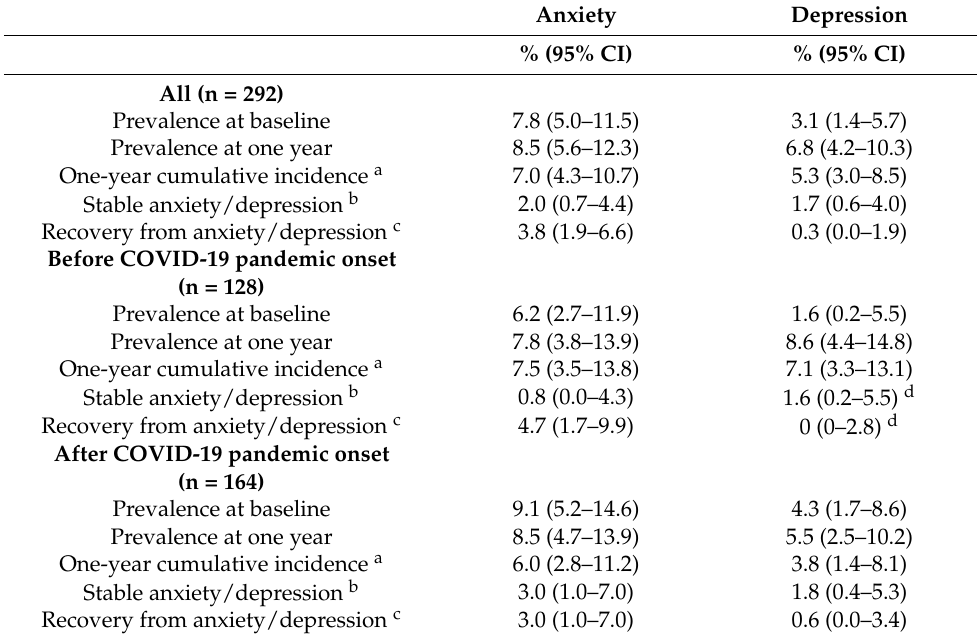
Table 2. Anxiety and depression states among patients with prostate cancer during the first year after cancer diagnosis, according to the time period, before or after COVID-19 pandemic onset, in which the one-year evaluation was